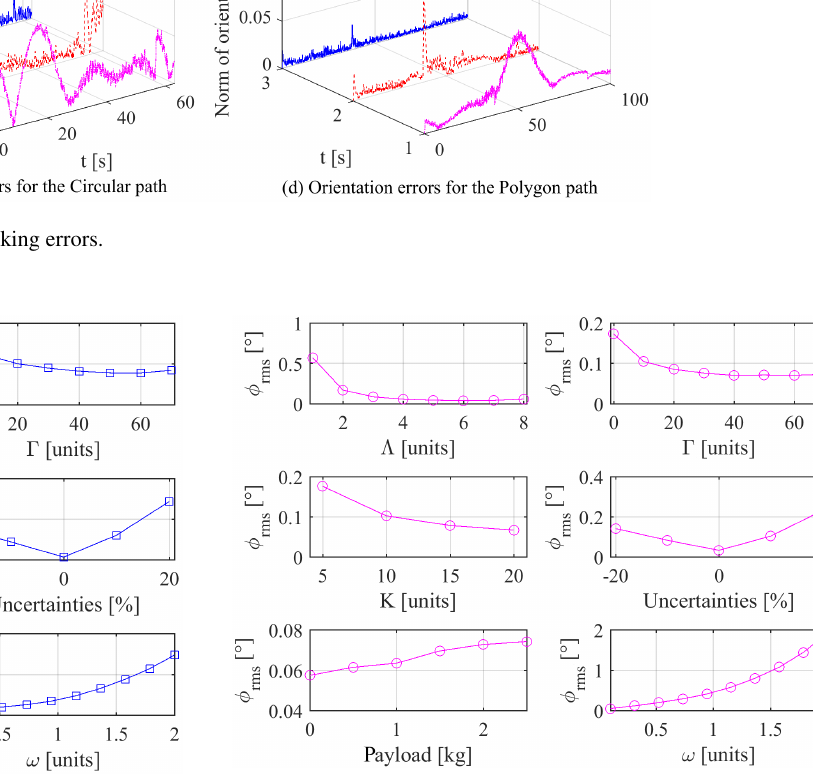
Figure 8. Controller parameter sensitivity and robustness analysis results: Parameter variations vs. Root-mean-square error of end- effector positions.